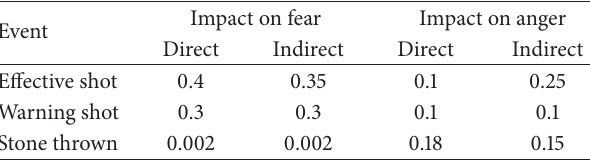
Table 2: Main event impacts on fear and anger. Impact on fear Impact on anger Event Direct Indirect Direct Indirect Effective shot 0.4 0.35 0.1 0.25 Warning shot 0.3 0.3 0.1 0.1 Stone thrown 0.002 0.002 0.18